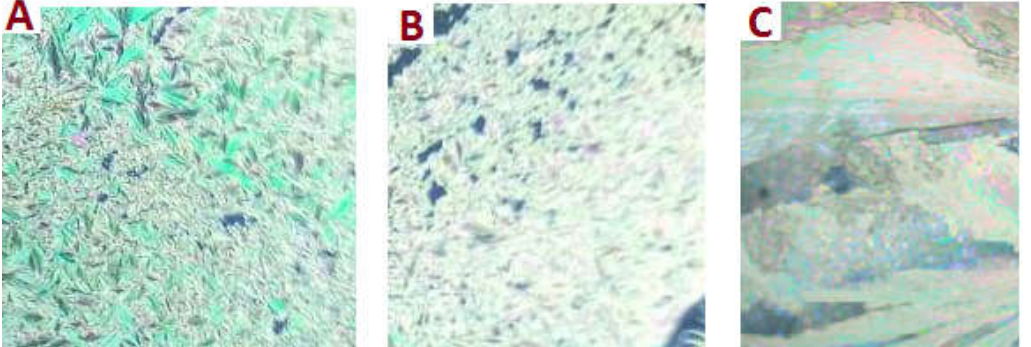
Figure 2. Optical photomicrographs under polarized optical microscopy (POM) of the compound 2c during the cooling scan. ( A ) Smectic-A mesophase at 267 °C, ( B ) Smectic-C mesophase at 220 °C and ( C ) Crystal phase at 90 °C.